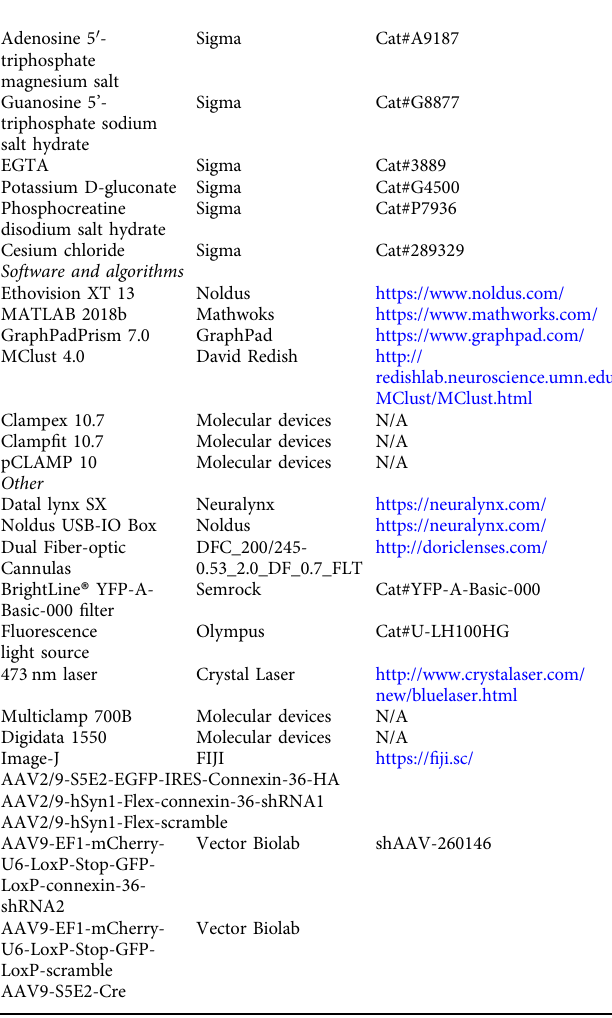
Animals . To generate Pv-Cre; WT/ Shank2 – / – mice, Shank2 + / – mice lacking exons 6 + 7 15 were crossed with Pv-Cre mice (#8069; Jackson Laboratory) 79 . Hetero- zygous Pv-Cre male 30 mice over the age of 12 weeks were used for all the experiments except for the patch experiment shown in Fig. 3h – k, where we used female mice, partly based on the previous report that male and female Shank2-KO mice show comparable levels of behavioral abnormalities 15 . Experimental